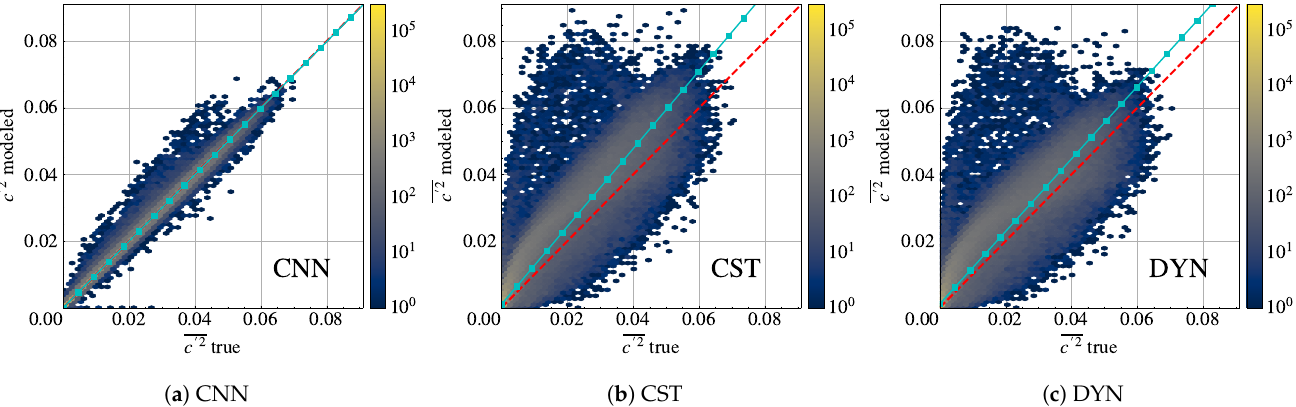
Figure 6. Hexbin plots of model predictions against ground truth: ( a ) CNN model, ( b ) CST model, ( c ) DYN model. Data points are gathered in hexagonal bins and colored according to the number of data points they contain. The red line y = x represents a perfect model. Cyan lines represent linear trends of the